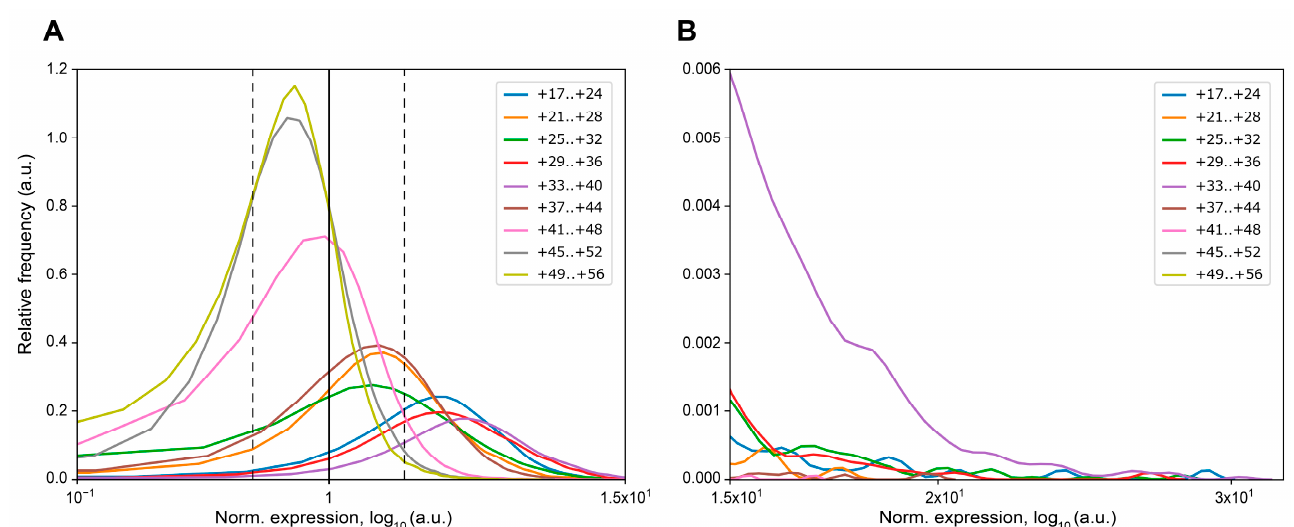
Figure 4. Kernel density estimation of normalized expression values for the MPRA libraries that were averaged over replicates and normalized to the wildtype reference construct. ( A ) Density plot with a scale ranging from 1.0 × 10 − 1 to 1.5 × 10 1 . The expression level of the wildtype reference construct is indicated by a solid black vertical line. The twofold changes in the expression levels are depicted by dotted black vertical lines. ( B ) Density plot with a scale ranging from 1.5 × 10 1 to 3.2 × 10 1 . Table 2. Number of mutations influencing the eGFP expression in the MPRA libraries.